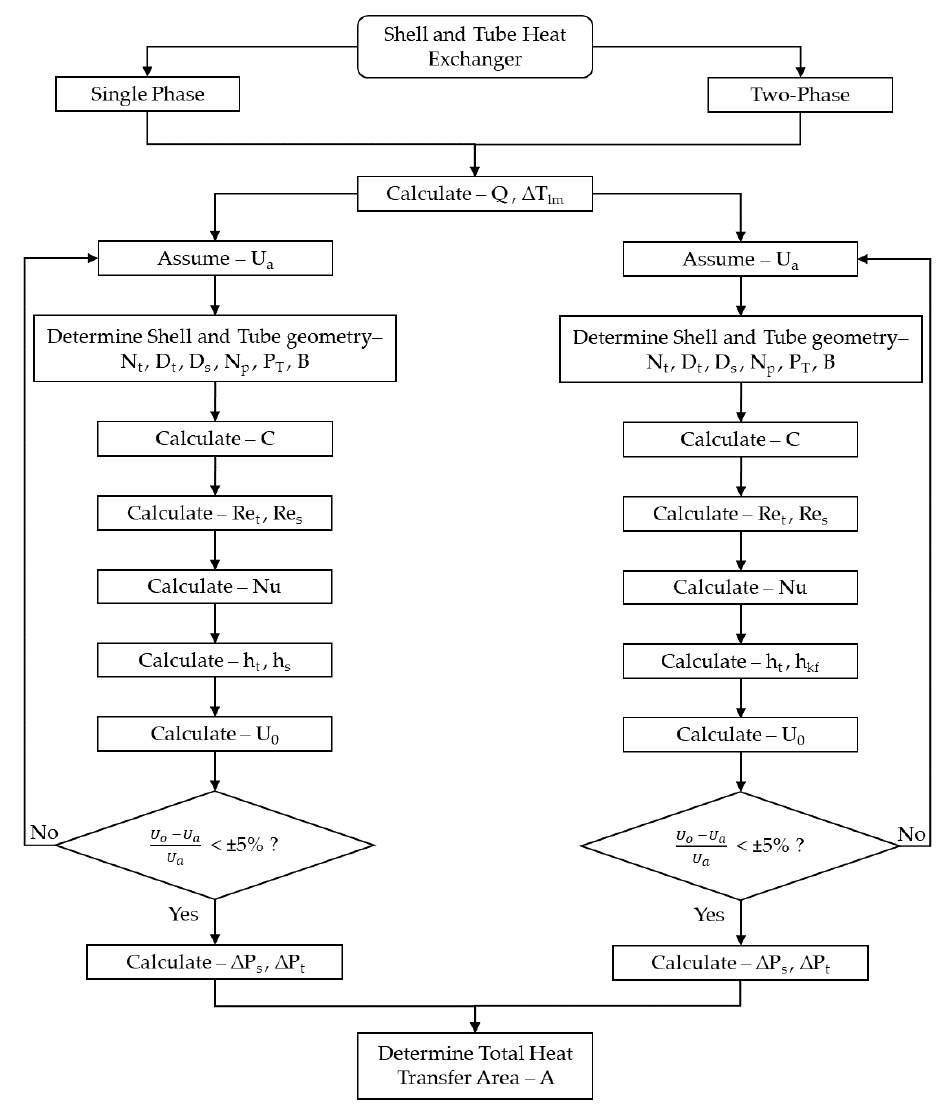
Figure 5. Design method flow chart for shell and tube heat exchanger sizing for the single phase and two-phase